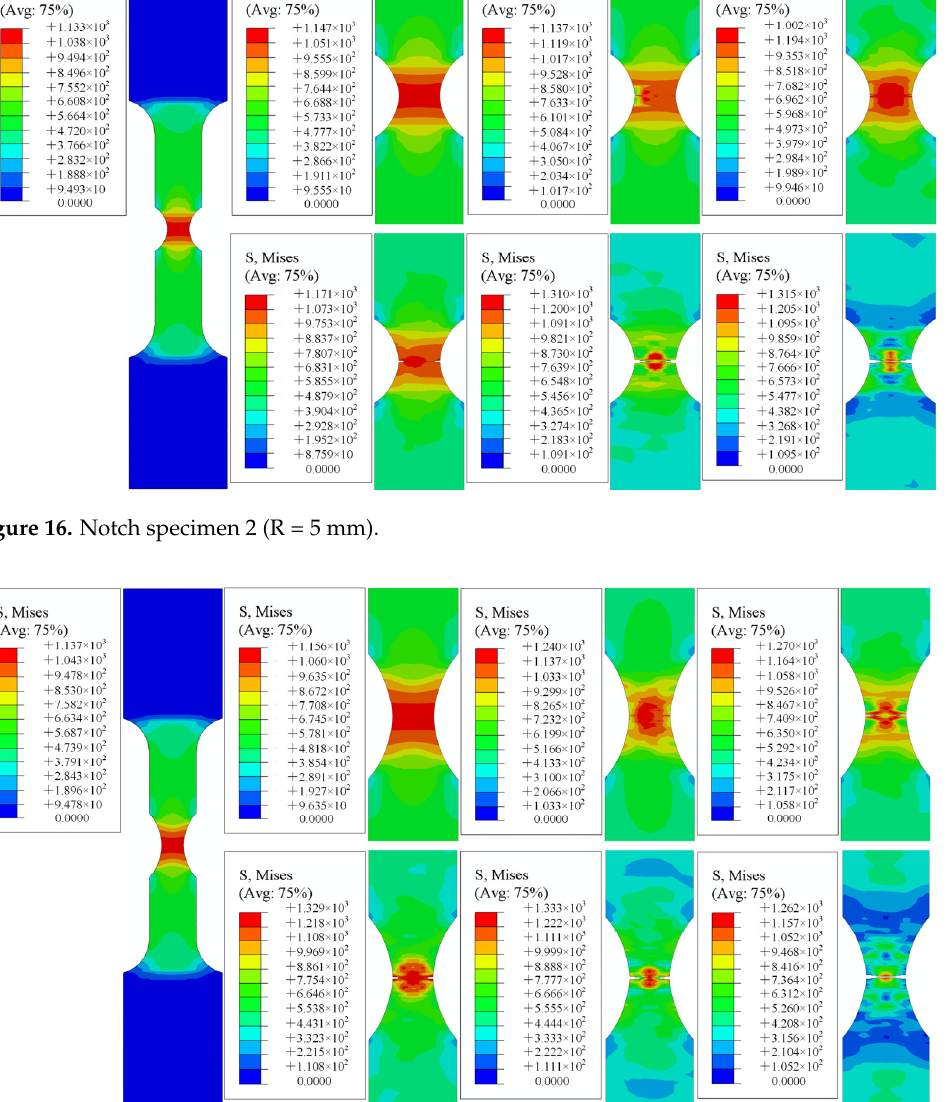
Figure 17. Notch specimen 3 (R = 10 mm).